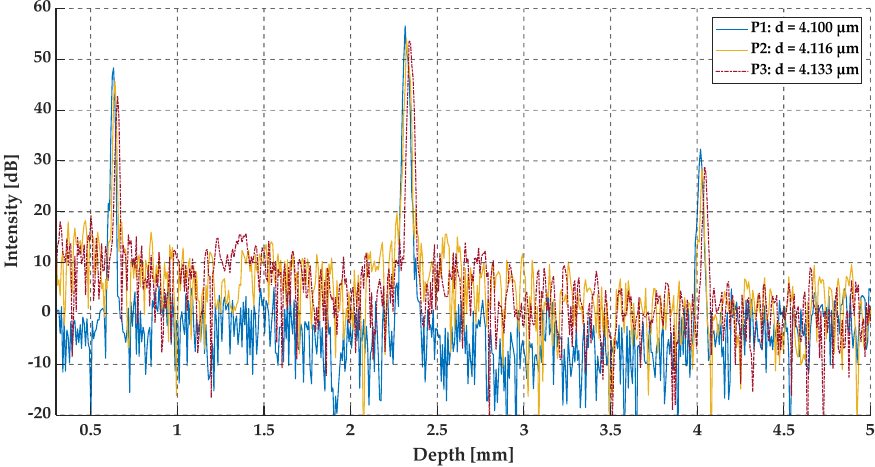
Figure 14. The A-scans at positions P1, P2, and P3.